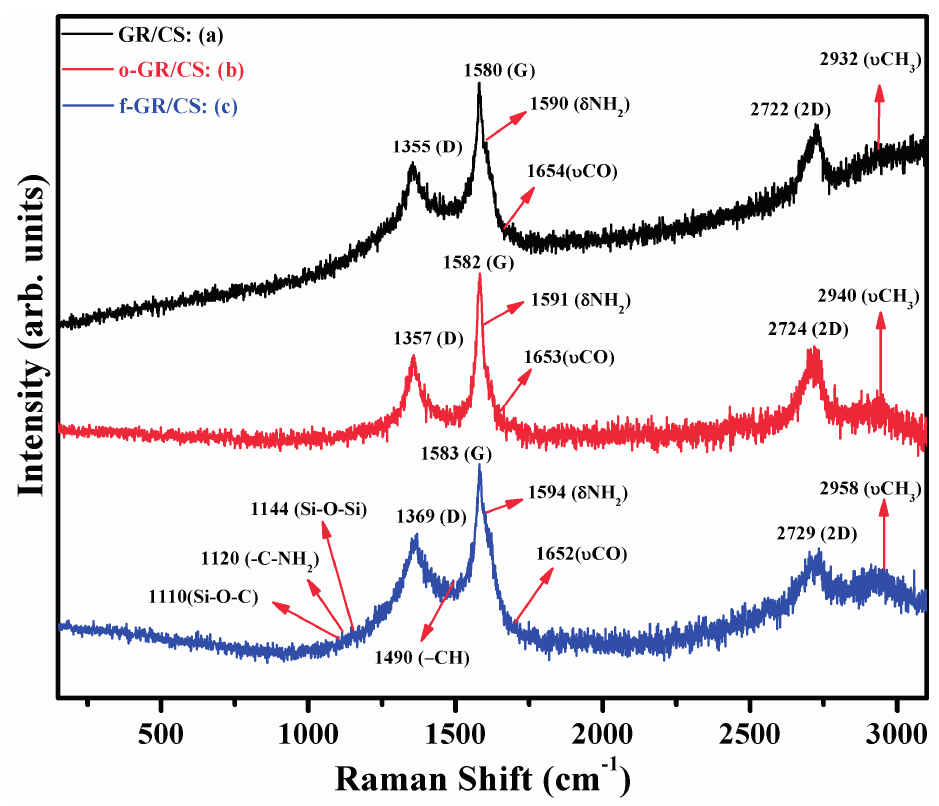
Figure 6. Raman spectrums of GR/CS, o-GR/CS and f-GR/CS composite